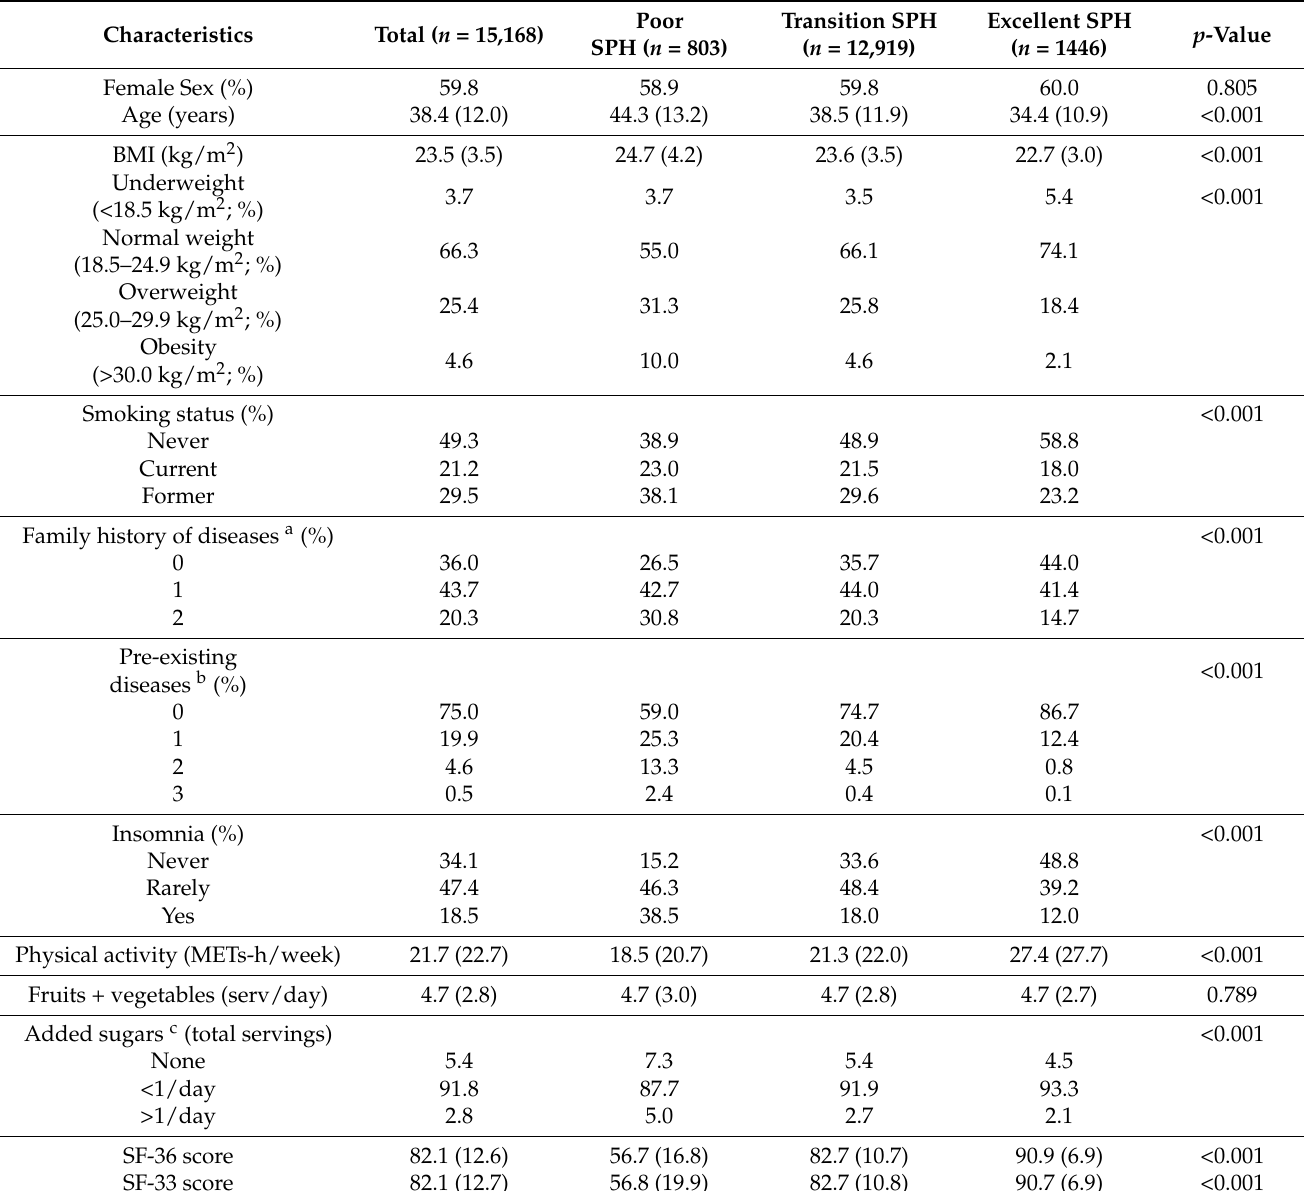
Table 1. Baseline characteristics of participants categorized by Item 1 of the SF-36 (In general, would you say your health